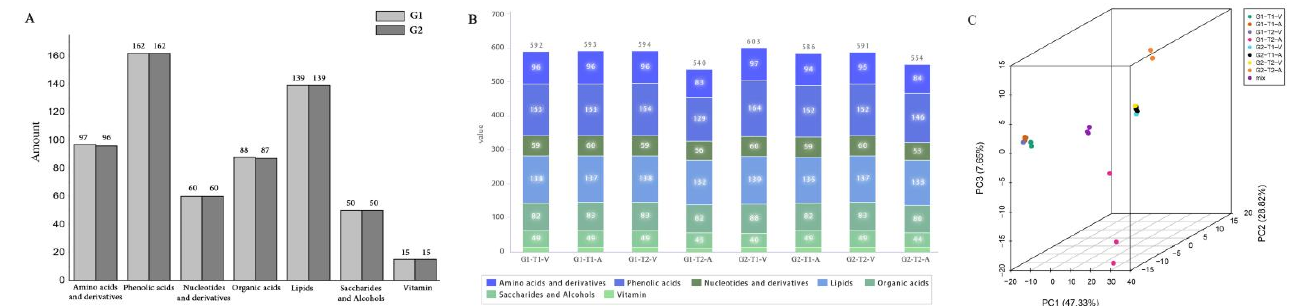
Figure 1. Total ion current of one quality-control sample according to mass spectrometry detection ( A ) and the multi-peak detection plot of metabolites in the multiple-reaction-monitoring mode ( B ).